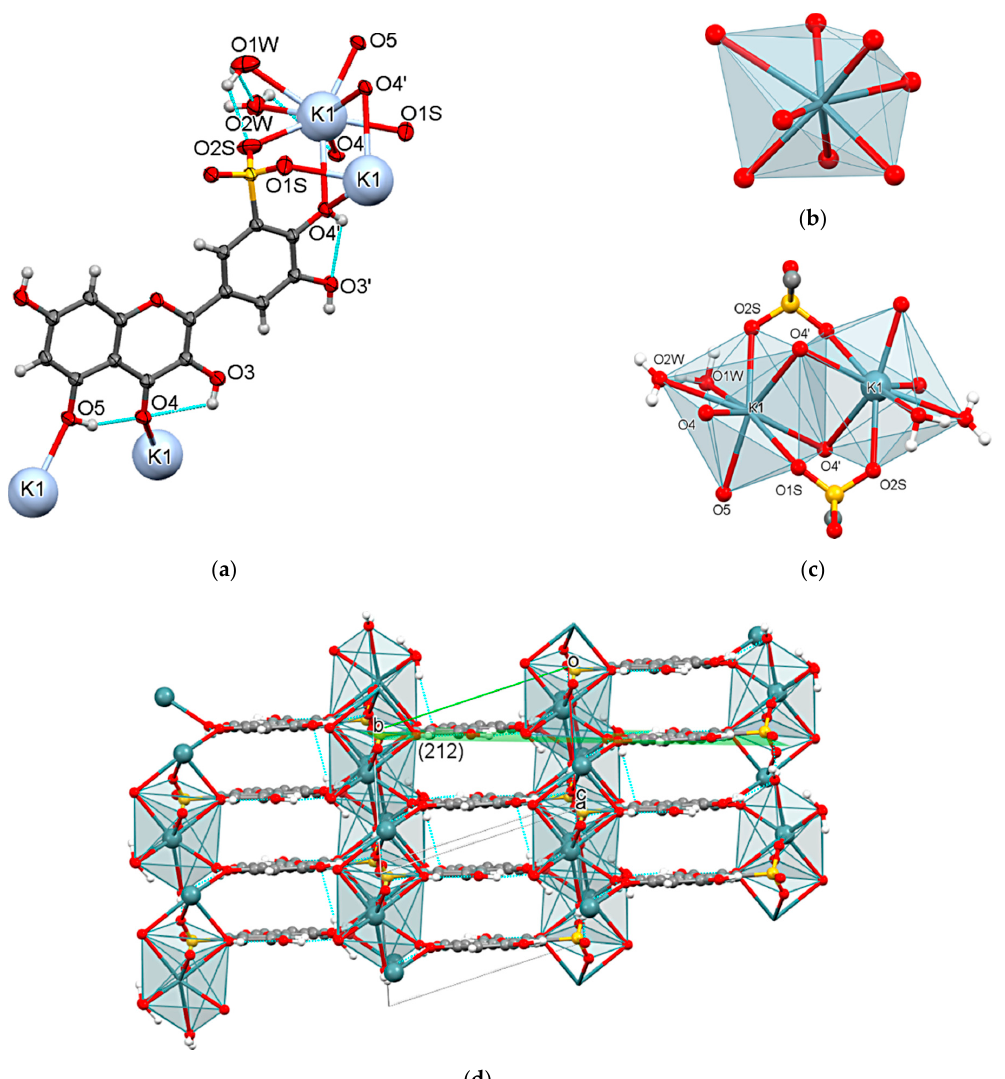
Figure 2. V iew of the crystal structure of 1 . ( a ) The K + cation…QSA¯ anion interactions. Dashed lines indicate intramolec- ular O-H…O hydrogen bonds. ( b ) Coordination sphere of K + cation. ( c ) The K 2 O 14 dimer. ( d ) The planes of aromatic rings of the QSA¯ anion are parallel to the crystallographic plane (212). Table 2. The geometry of the cation K + coordination sphere in 1 .